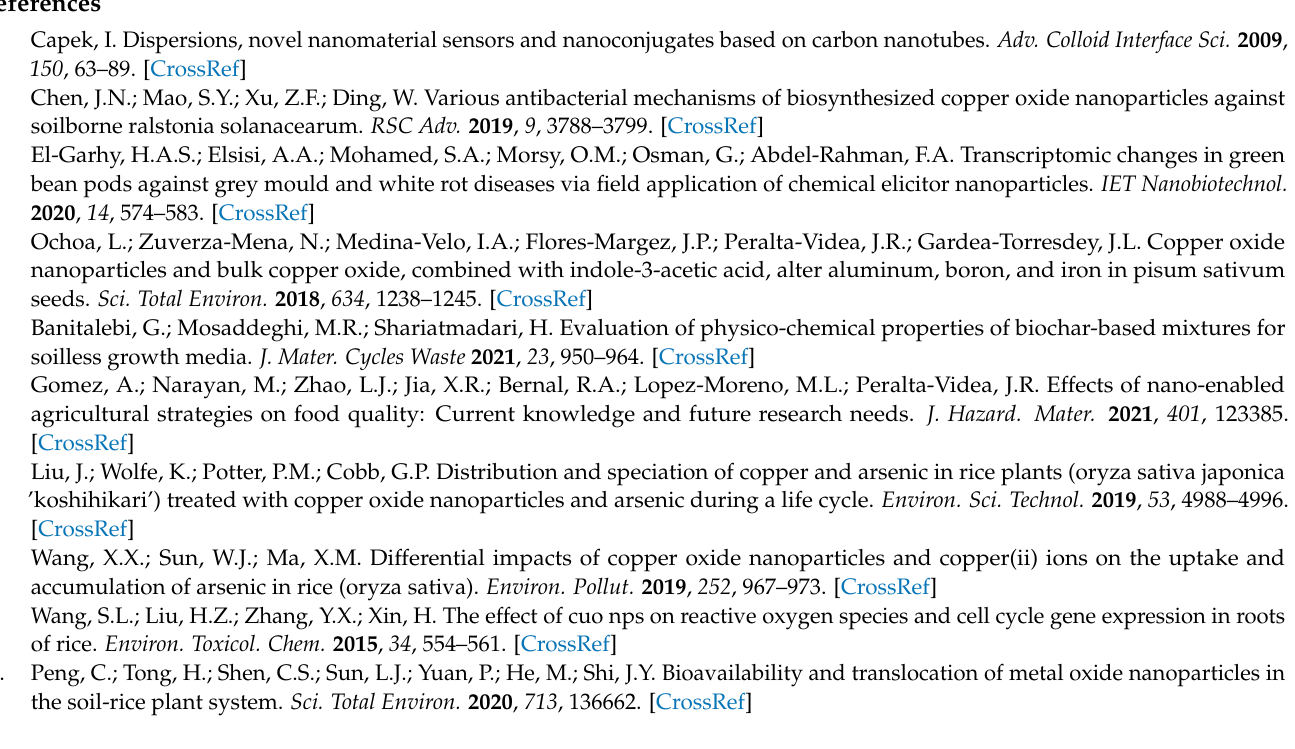
Figure S2: The culture system of rice seedlings in this study. (treatments from left to right in image (A) were CK, 0.5A, 1A, 0.5B and 1B, respectively; (B): 0.5A, 0.5A+50, 0.5A+100, 1A, 1A+50, 1A+100 treatments; (C): 0.5B, 0.5B+50, 0.5B+100, 1B, 1B+50, 1B+100 treatments.), Figure S3: The concentrations and ratios of different species As in the roots (A) and shoots (B), Figure S4: TEM-EDS analysis of rice root under different treatments. D is the magnify view of C. E and F are the EDS spectrum of B and D respectively, Figure S5: Pearson correlation between Cu and As concentration in rice root (A) and shoot (B), Figure S6: Root and shoot biomass of rice, Table S1: Primer sequences for q-PCR, Table S2: The two-way ANOVA and Tukey multiple range tests for the effects of As(III) + CuO NPs on the Cu and As concentrations in rice, Table S3: The two-way ANOVA and Tukey multiple range tests for the effects of As(V) + CuO NPs on the Cu and As concentrations in